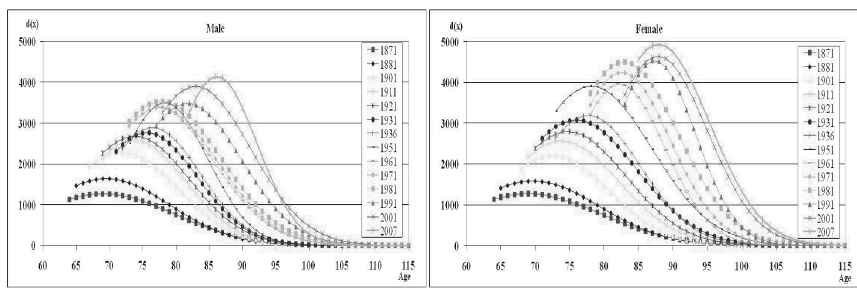
Figure 9 – Distribution of death fitted with a scaled normal distribution (1871-2007).